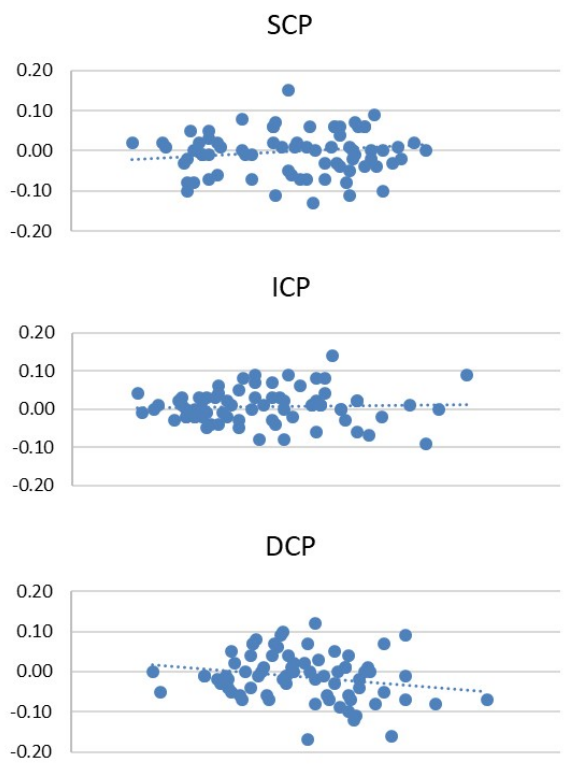
Figure 2. Bland–Altman plots of the first and the second scan of SCP, ICP and DCP.